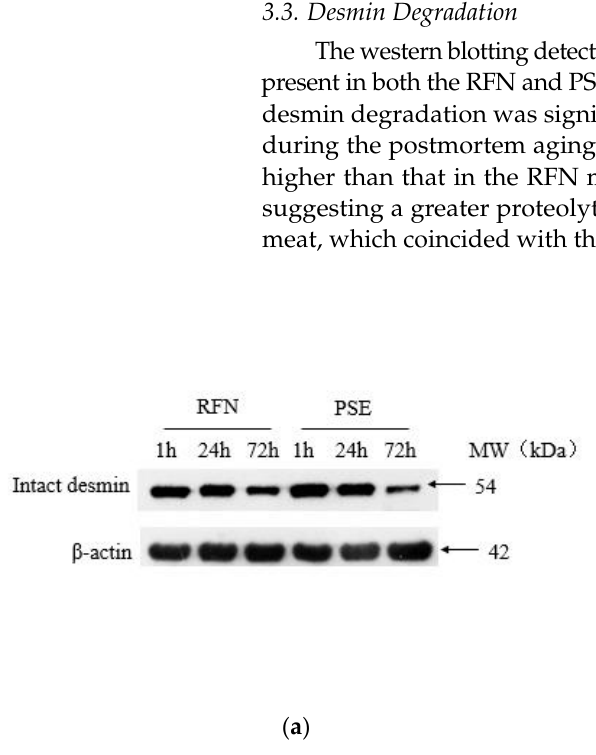
Figure 2. ( a ) Intact desmin contents at 1 h, 24 h, and 72 h postmortem of red, firm and non-exudative (RFN), and pale, soft and exudative (PSE) meat; ( b ) relative intensity of intact desmin in the RFN and PSE meat at 1, 24, and 72 h postmortem. Mean value ± standard error ( n = 4). a,b Values within the same aging time between the different groups are significantly different ( p < 0.05). A,B Values within the same group at different aging times are significantly different ( p < 0.05).